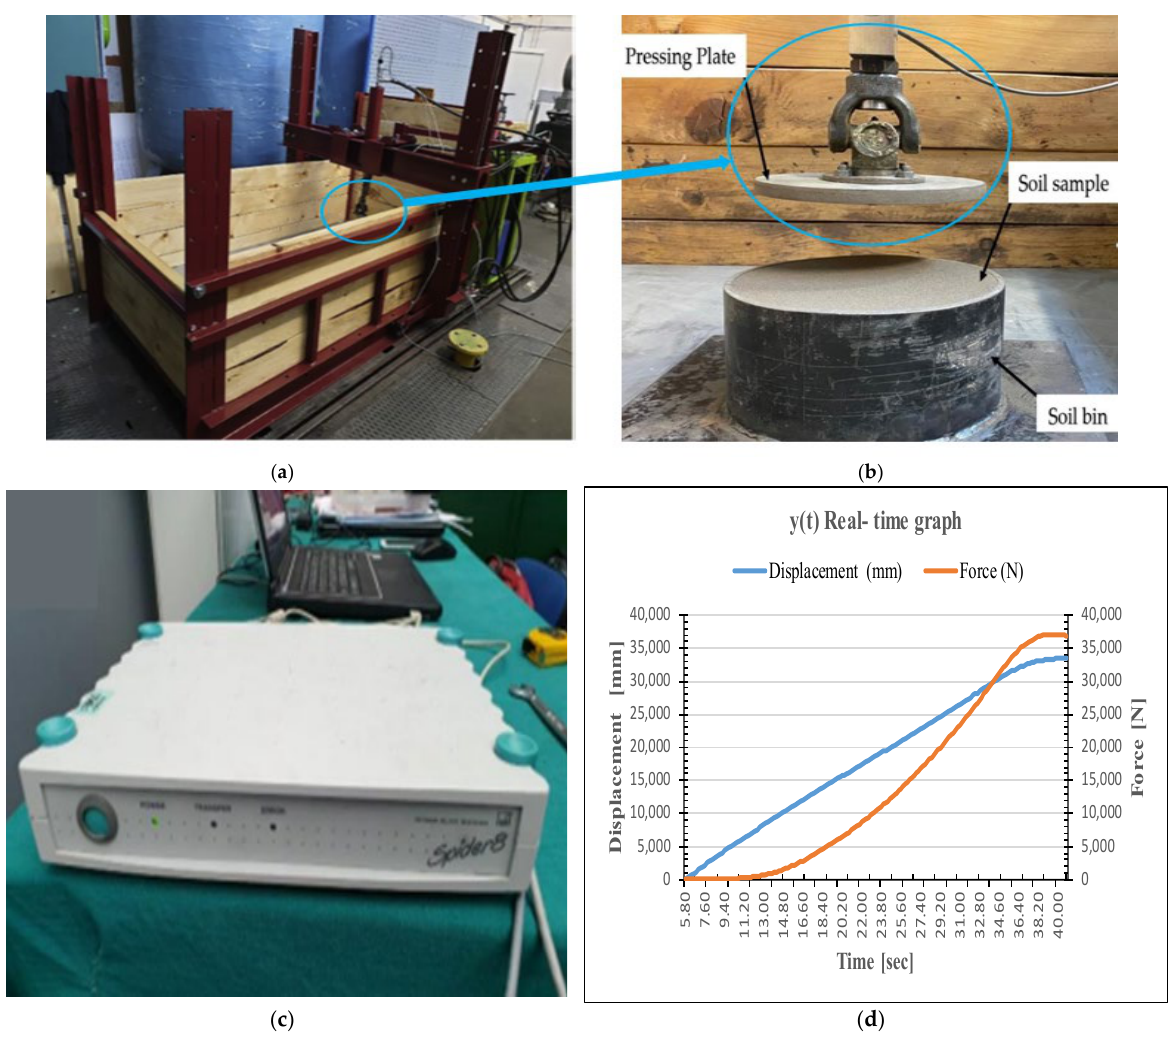
Figure 1. Shows ( a ) the main structure of the Bevameter equipment; ( b ) the plate size (diameter = 20 cm), the soil bin (height = 12 cm, inner diameter = 22 cm), and the soil sample; ( c ) the data logger (Spider8); and ( d ) the CATMAN 4.5 software recording the data (force and displacement as a function of time).